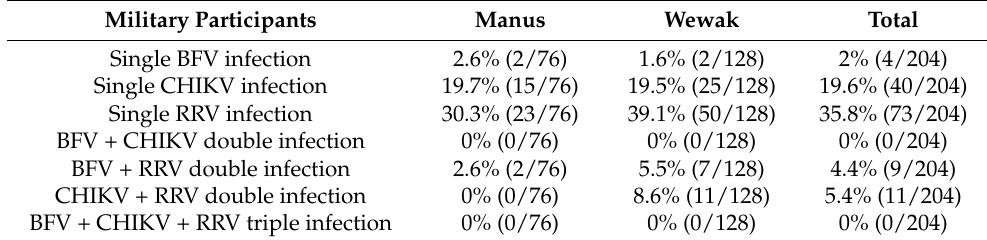
Table 4. Co-infection of Barmah Forest virus, Chikungunya virus and Ross River virus among Papua New Guinea military personnel in